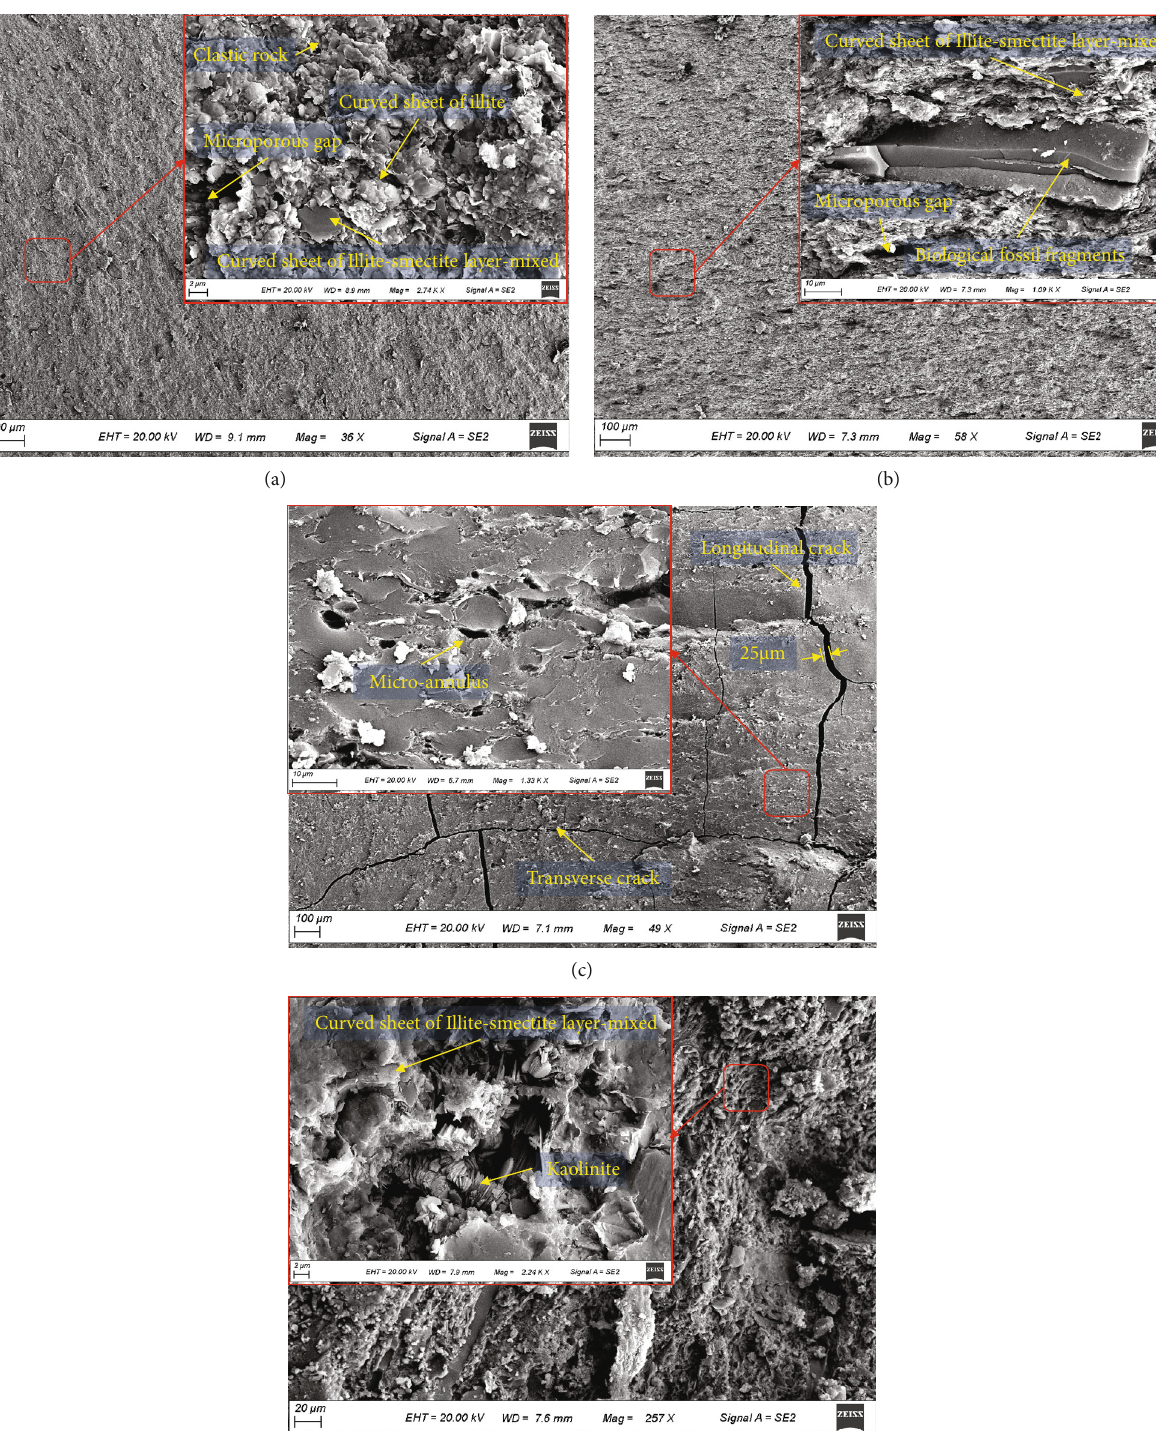
Figure 6: SEM of surrounding rock. (a, b) SEM of mudstone. (c, d) SEM of